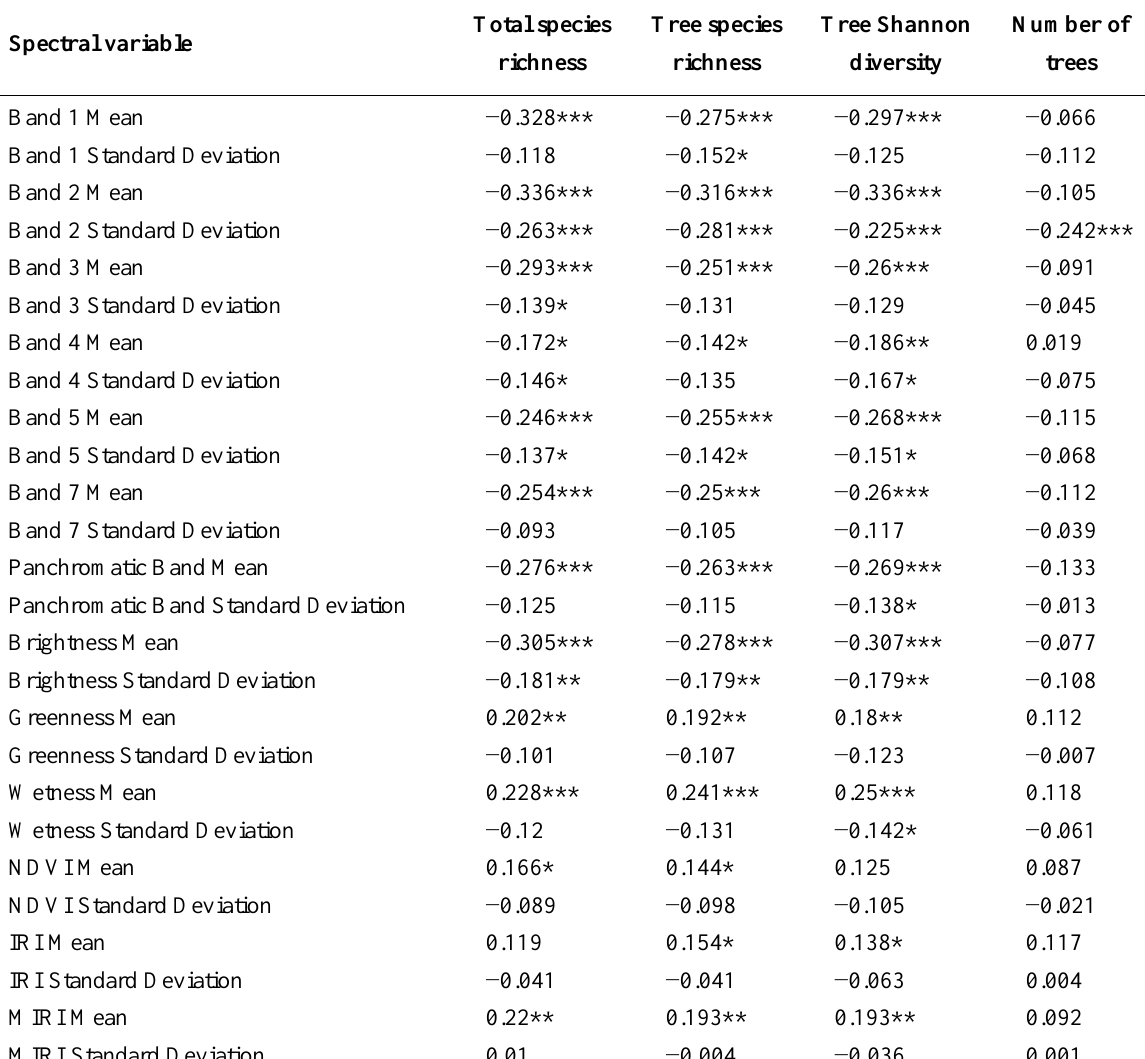
Table 1. Pearson correlation coefficients for species diversity vs . Landsat ETM+